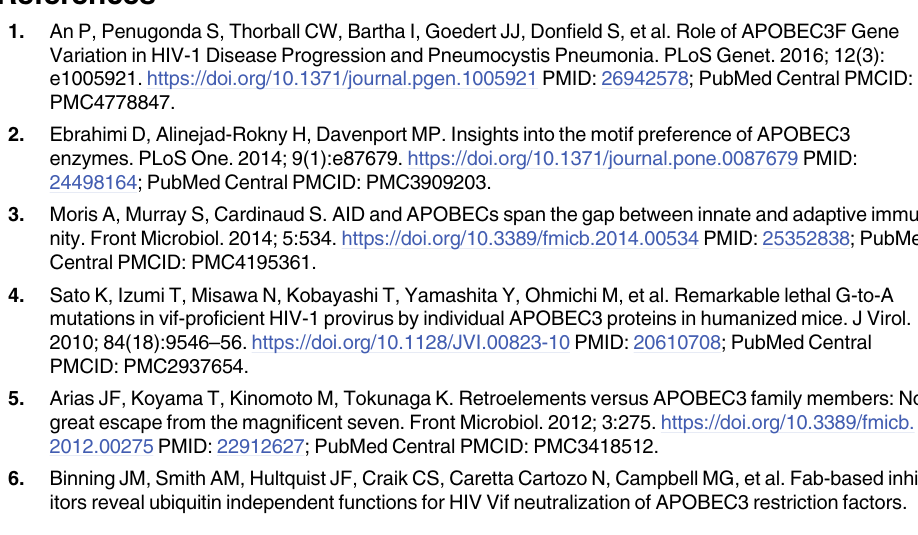
Fig 3. RNA levels and CD4+ cell counts. Comparisons of RNA levels per ml (upper boxes) and counts of CD4+ cells per ml (lower boxes) between the sequences with stop codons at the tryptophan (grey boxes) and sequences without stop codons (white boxes). In the boxes the center lines show the medians; box limits indicate the 25th and 75th percentiles. Whiskers extend 1.5 times the interquartile range from the 25th and 75th percentiles, outliers are represented by open dots. RNA levels (upper boxes) are shown in log scale.